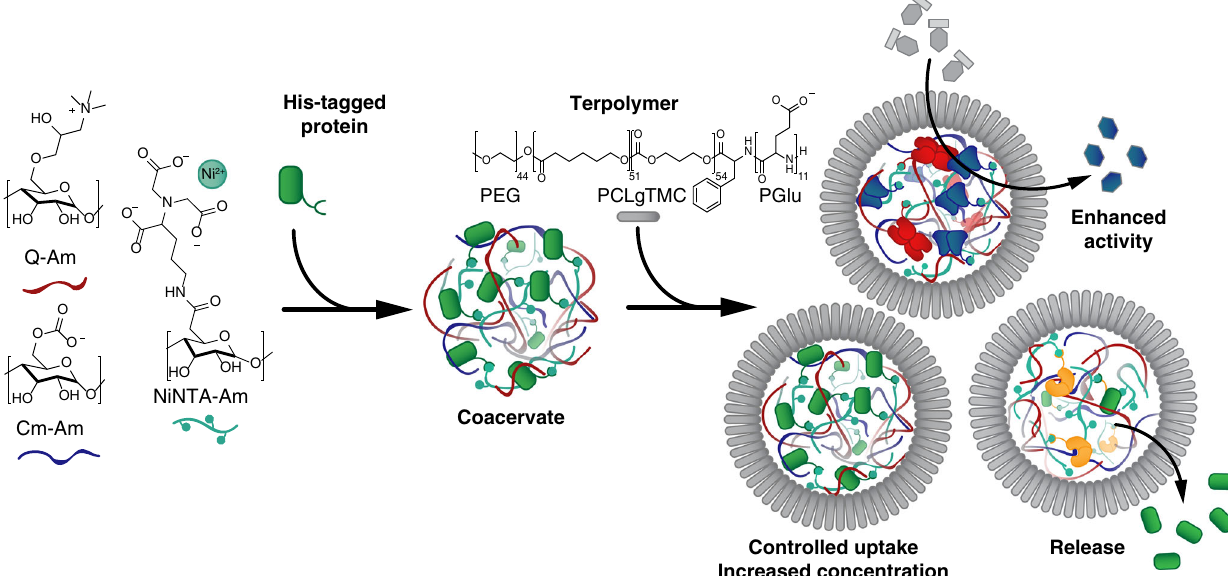
Fig. 1 Schematic overview of chemically programmed loading of His-tagged proteins into Ni2 + -NTA-functionalized protocells. Q-Am (red), Cm-Am (blue), and Ni-NTA-Am (teal) are mixed to form a coacervate droplet in which His-tagged proteins are loaded. Upon addition of the terpolymer, the droplets are stabilized. These stabilized coacervates can be loaded with functional cargo to allow for an enhanced enzymatic activity or protease-mediated